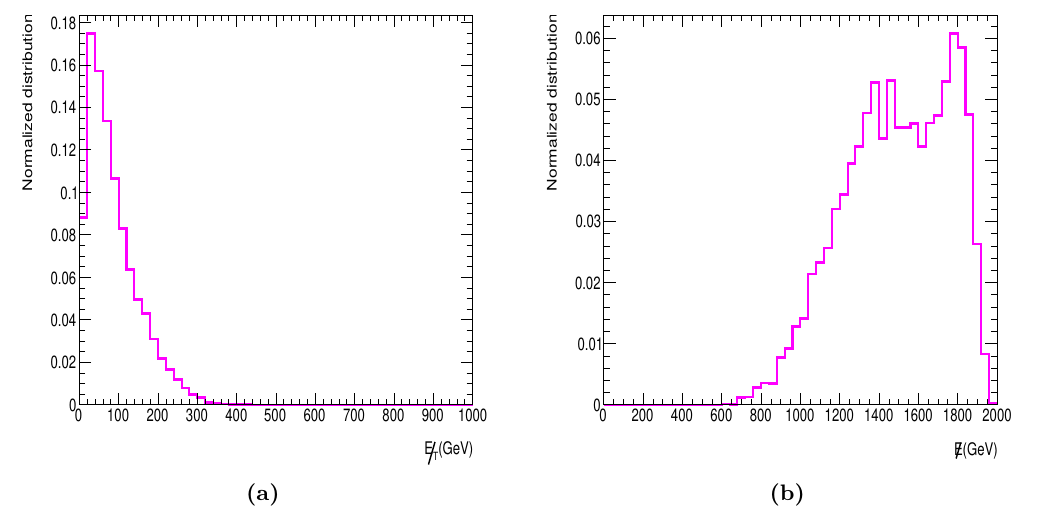
Figure 5. Same as figure 3, with { m DM duction cross-sections for the heavier HDSP is assumed to be one quarter of that of the lighter ones √ at s = 2000 GeV.